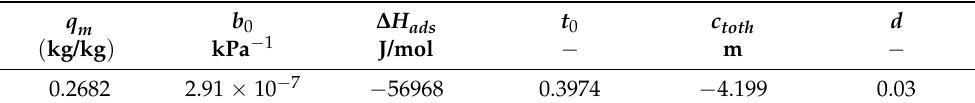
Table 4. Equilibrium model parameters